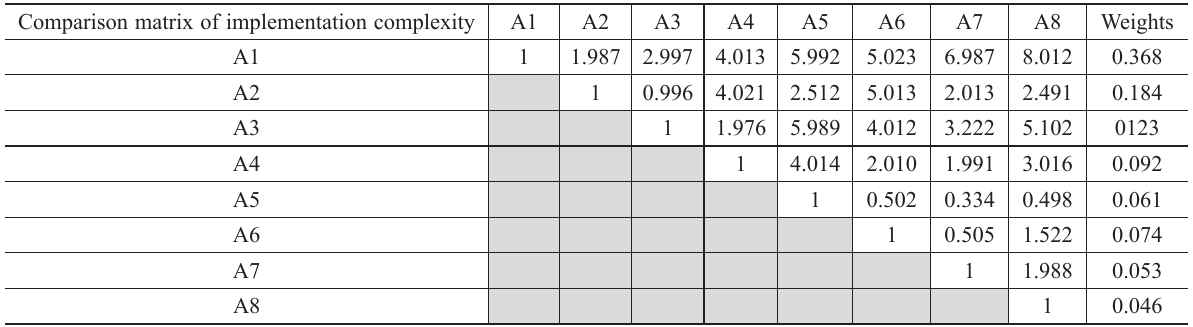
Table 10. Importance degree of any laminated glass models related to implementation complexity Comparison matrix of implementation complexity